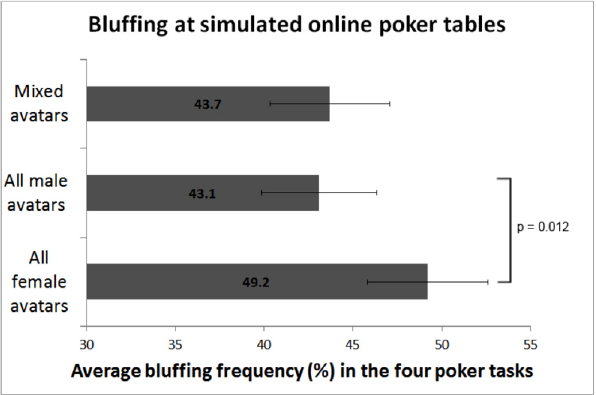
Fig 1. Average bluffing frequency (%) in the four poker tasks. Results are presented separately for three experimental conditions: poker table with 1) gender mixed (two female and two male), 2) all male, and 3) all female avatar opponents. The model is adjusted for Poker Experience Scale. Planned contrast between “ all male avatars ” and “ all female avatars ” groups is significant: B = 0.061, F (1, 498) = 6.41, 95% CI [0.01, 0.11], p = .012. Error bars represent 95% confidence intervals.